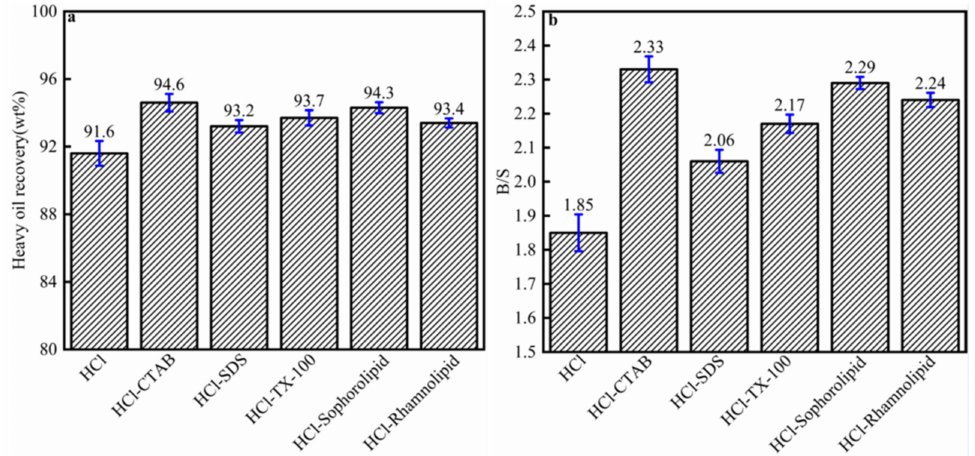
Figure 4. ( a ) Recovery; ( b ) B/S of heavy oil from different surfactants enhanced carbonate oil– solid separation.